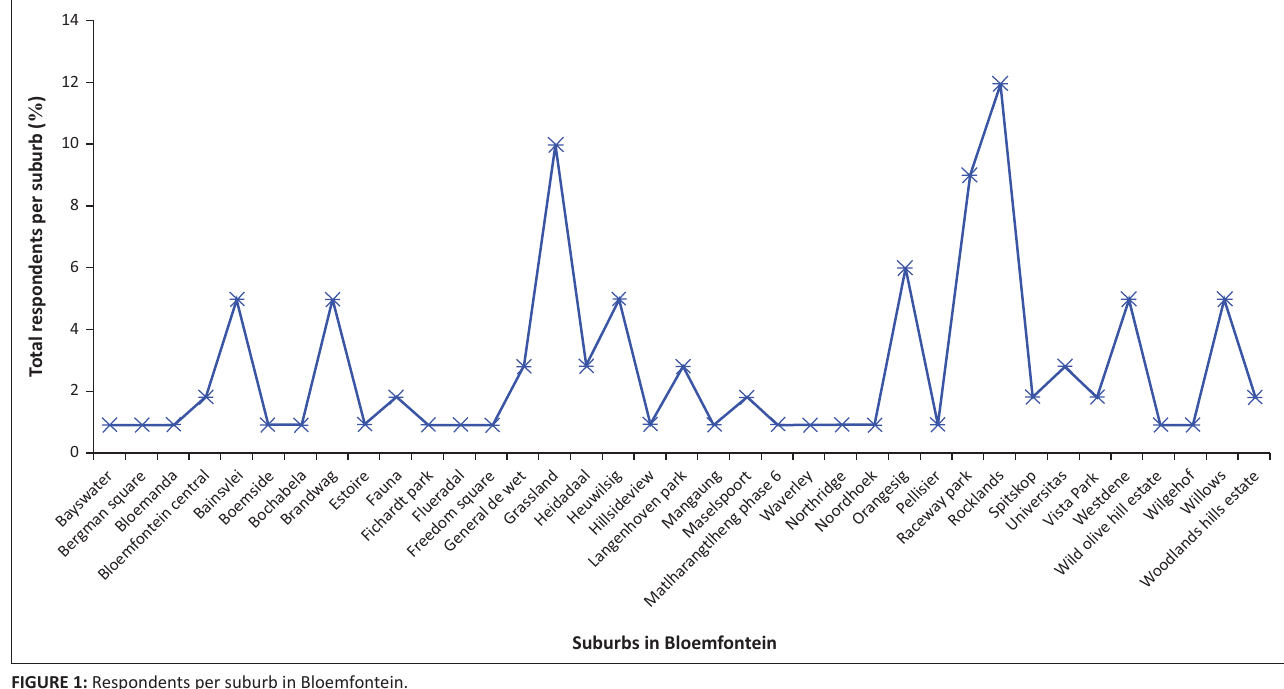
Avoid crowds and gatherings Clean and disinfect frequently touched objects